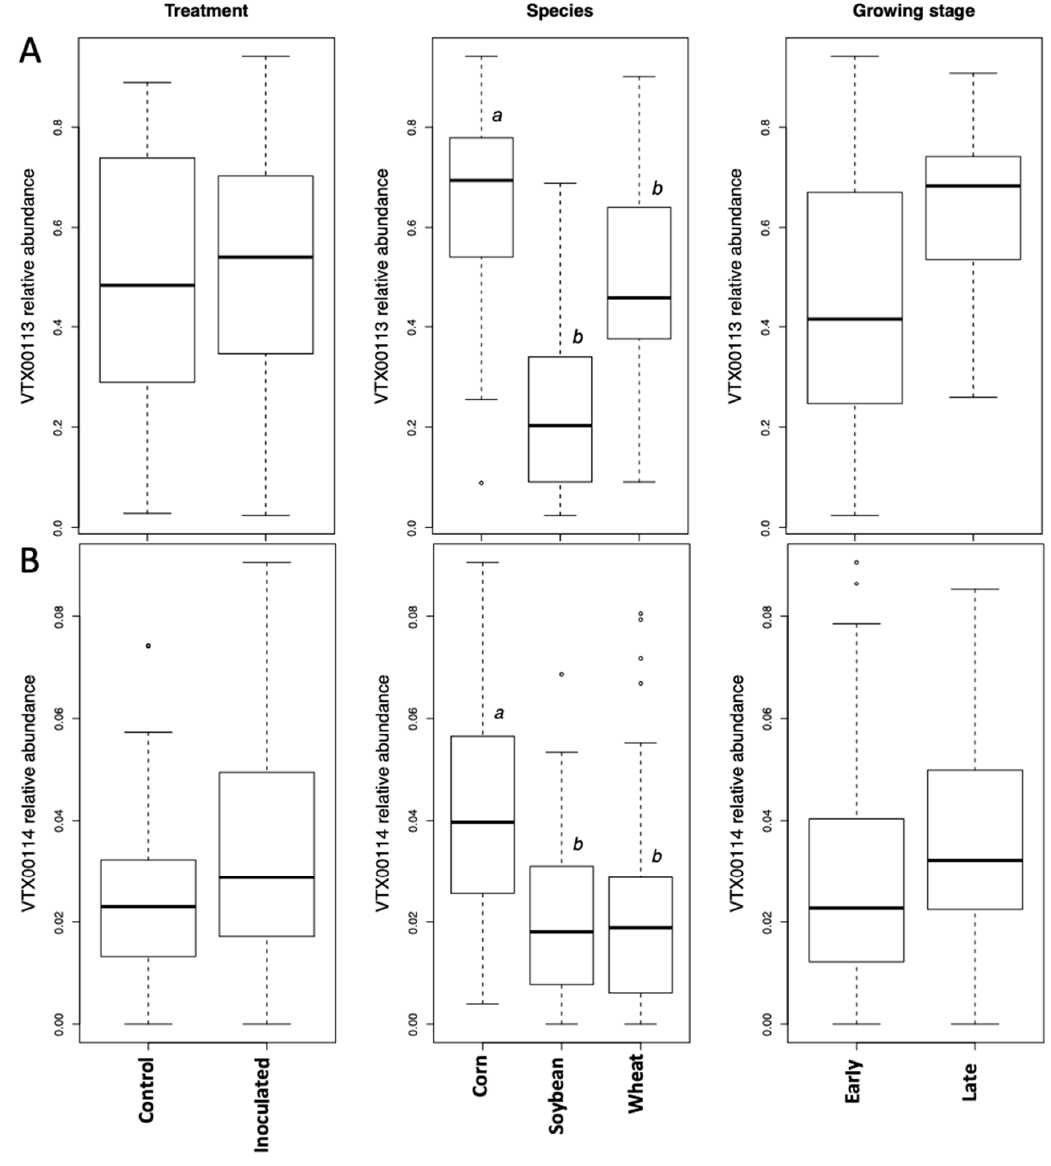
Figure 1. Relative abundance of the most abundant taxon Rhizophagus irregularis (VTX00113 ( A ) and VTX00114 ( B ). R. irregularis was represented by an average of 38% of reads across all samples in all three species (wheat, corn, and soybean) tested. Crop species and growth stage had a significant effect on the presence of VTX00113 and VTX00114. Letters a and b show statistically significant differences between variables.